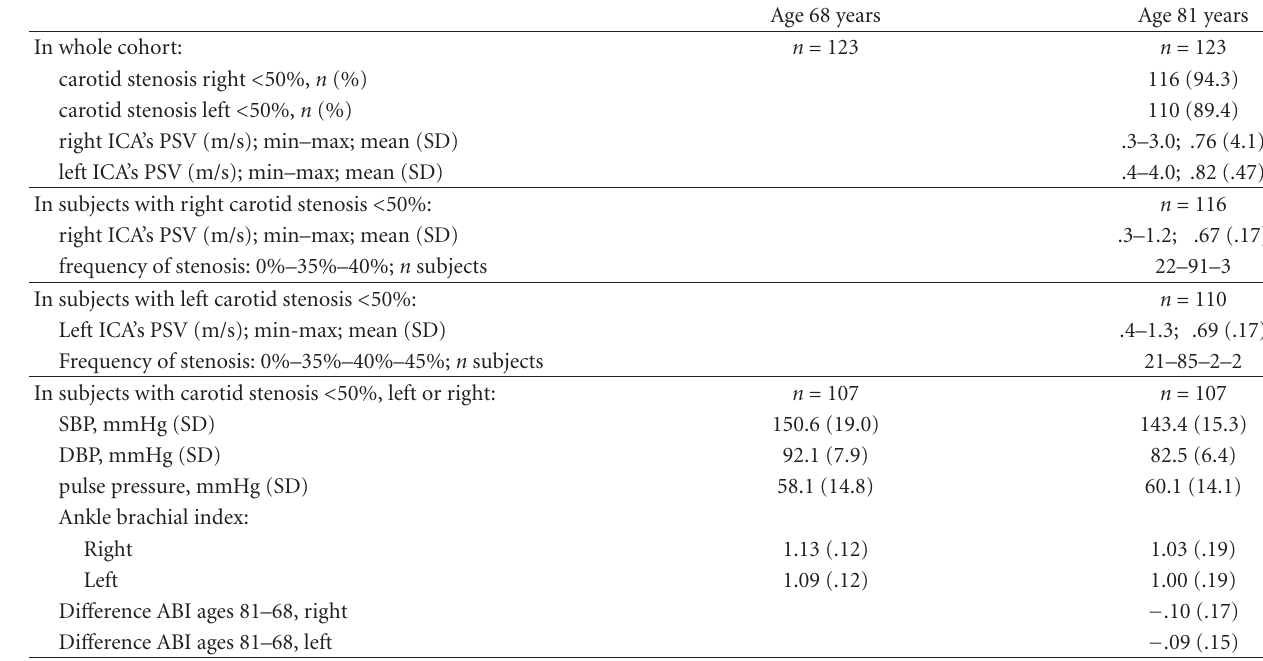
Table 1: The background data of the 123 subjects collected at the 1st and the 2nd followup of the cohort.